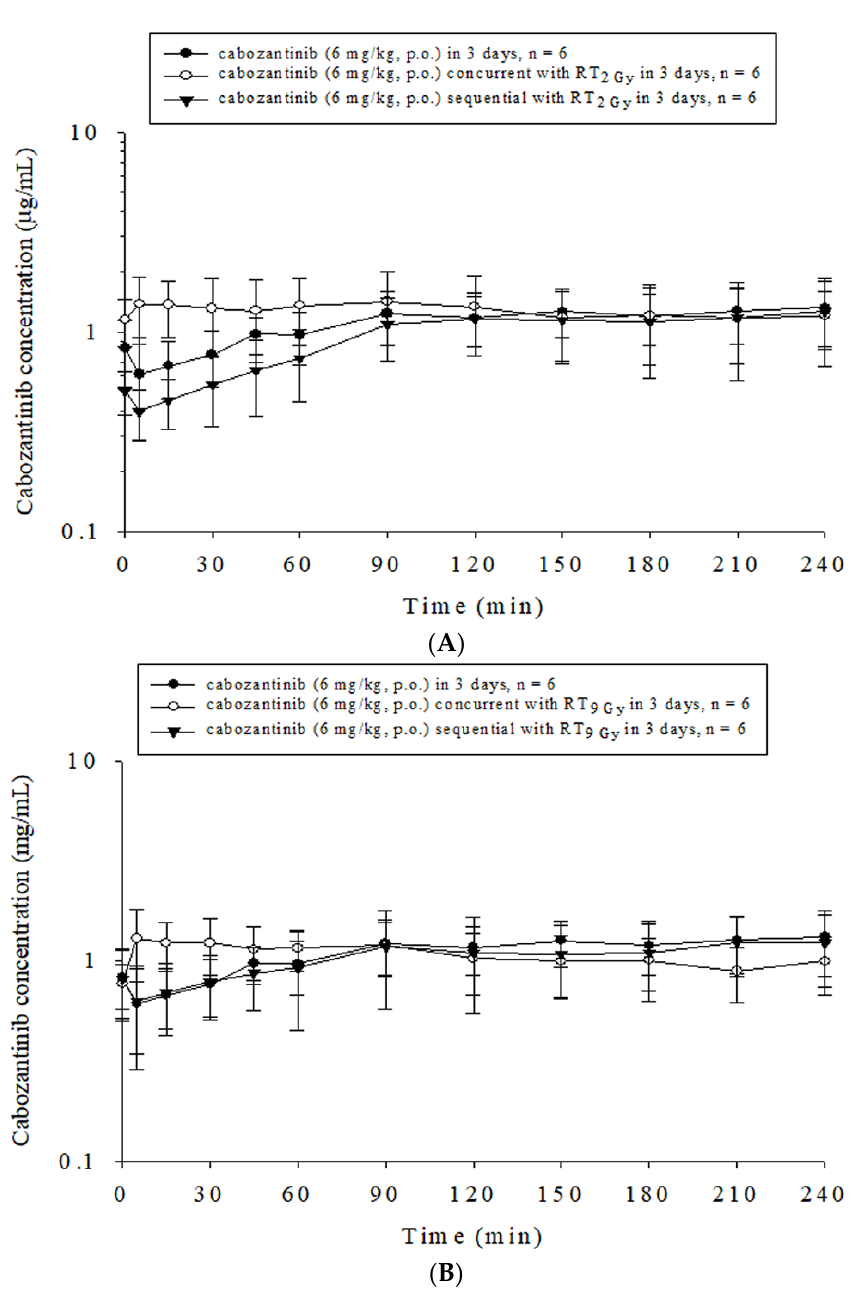
Figure 2. Concentration versus time curves of cabozantinib in the plasma of rats under different time courses with or without radiotherapy (RT). The treated groups included ( A ) the sham group, cabozantinib (p.o., q.d. × 3 d) with RT 0Gy (cabozantinib ×3 d ); the concurrent group, cabozantinib ×3 d 1 h after RT 2Gy in 3 fractions (RT 2Gy× 3 f’x ); the sequential group, cabozantinib ×3 d 24 h after RT 2Gy× 3 f’x ; ( B ) the sham group, cabozantinib ×3 d ; the concurrent group, cabozantinib ×3 d 1 h after RT 9Gy in 3 fractions (RT 9Gy× 3 f’x ); and the sequential group, cabozantinib ×3 d 24 h after RT 9Gy× 3 f’x . Data are expressed as the mean ± S.D. (n = 6 per group).